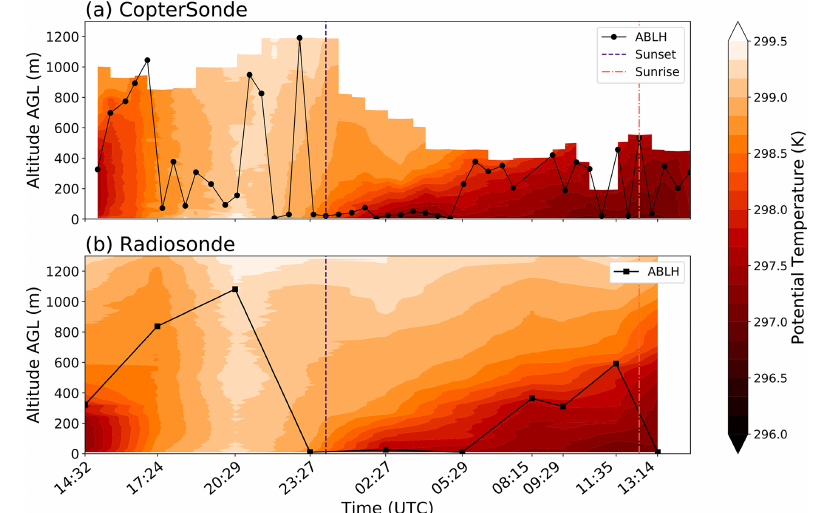
Figure 4. Potential temperature field (shaded contours) and black line indicating the ABL height determined by the height of the maximum potential temperature gradient on 5–6 October 2018 at KAEFS. (a) Each circle indicates the height determined by an individual flight. (b) Each square indicates the height determined by an individual radiosonde.